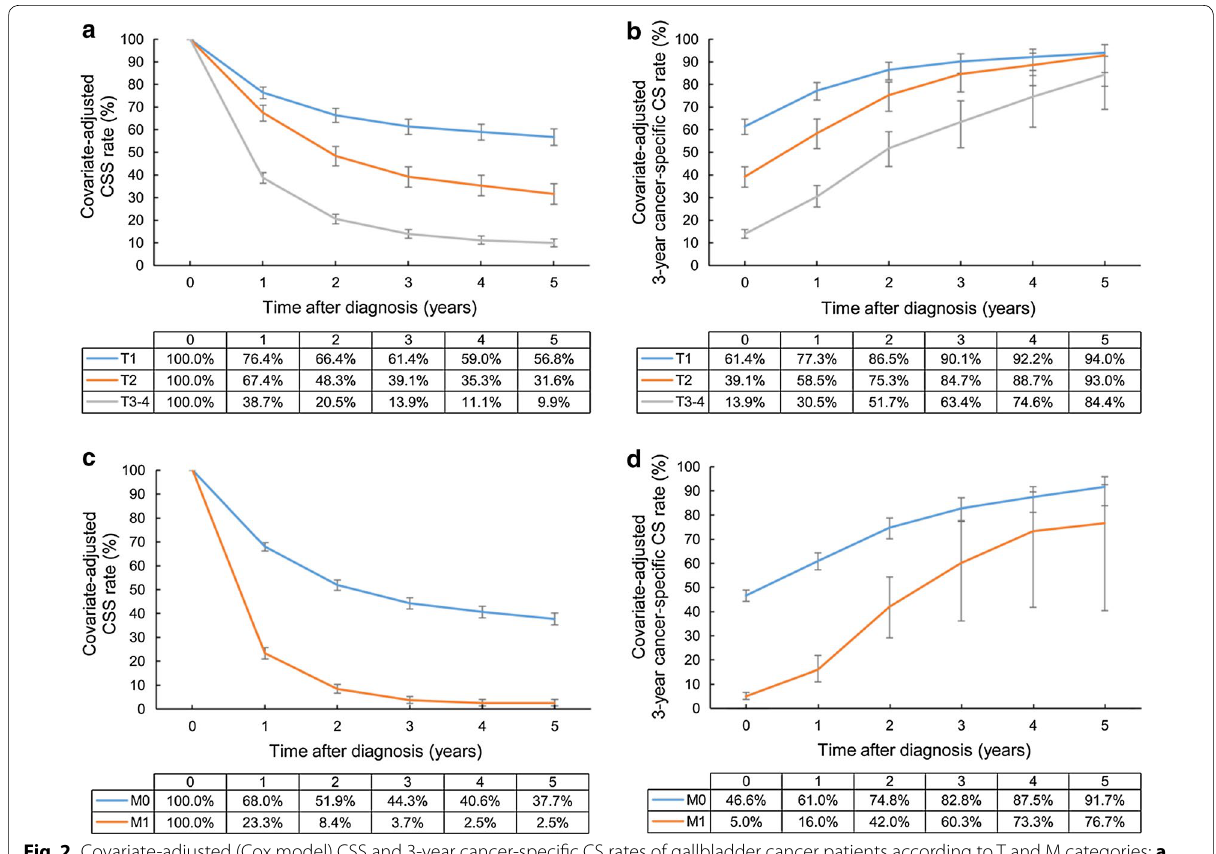
Fig. 2 Covariate‑adjusted (Cox model) CSS and 3‑year cancer‑specific CS rates of gallbladder cancer patients according to T and M categories: a CSS rates according to T category; b cancer‑specific CS rates according to T category; c CSS rates according to M category; d cancer‑specific CS rates according to M category. Error bars indicate 95% CIs. CSS cancer‑specific survival, CS conditional